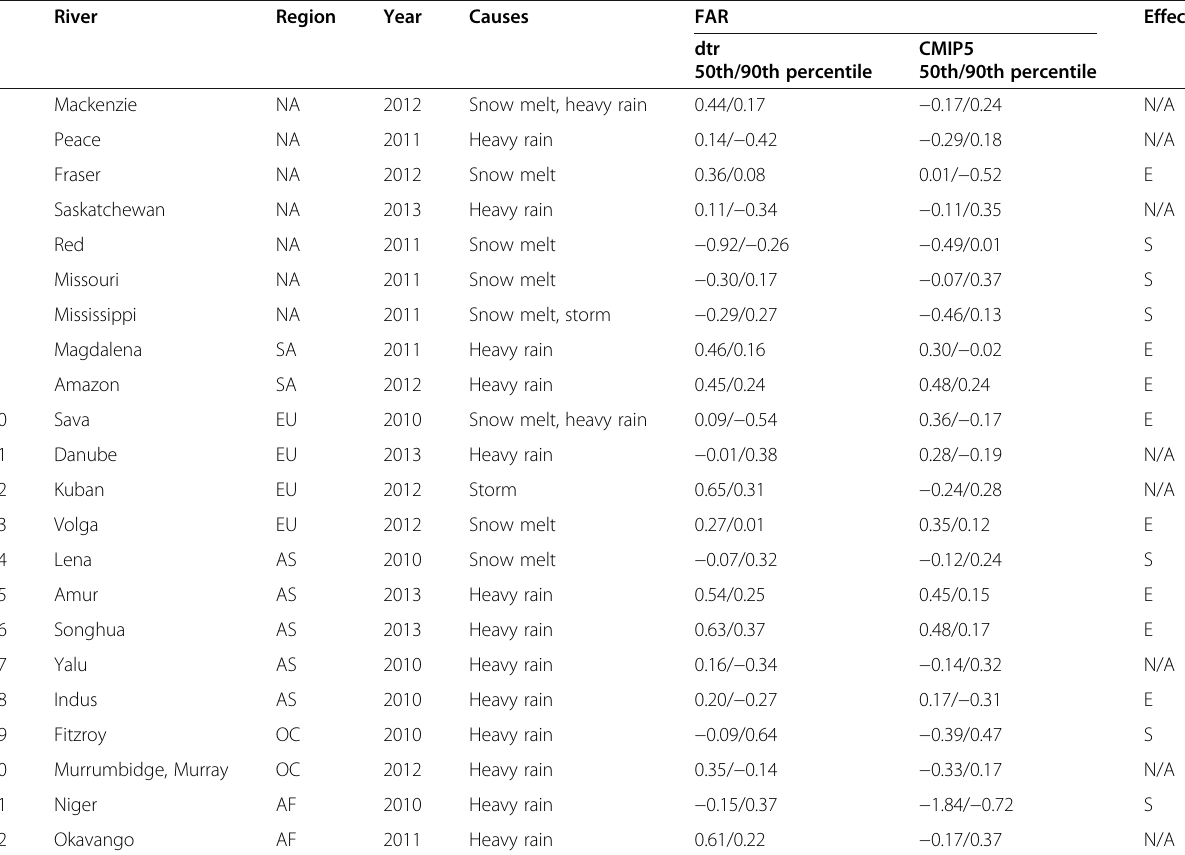
Table 2 Summary of selected flood events between 2010 and 2013. The effects of anthropogenic climate change on flood events (E, enhanced; S, suppressed; N/A, no significant effect) were judged as E (S) when both fraction of attribution (FAR 50 ) scores between ALL and NAT_dtr (dtr) and those between ALL and NAT_CMIP5 (CMIP5) show the same signal. The value of the 10th (90th) percentile of FAR (Table S1) is shown as FAR 90 when FAR 50 is positive